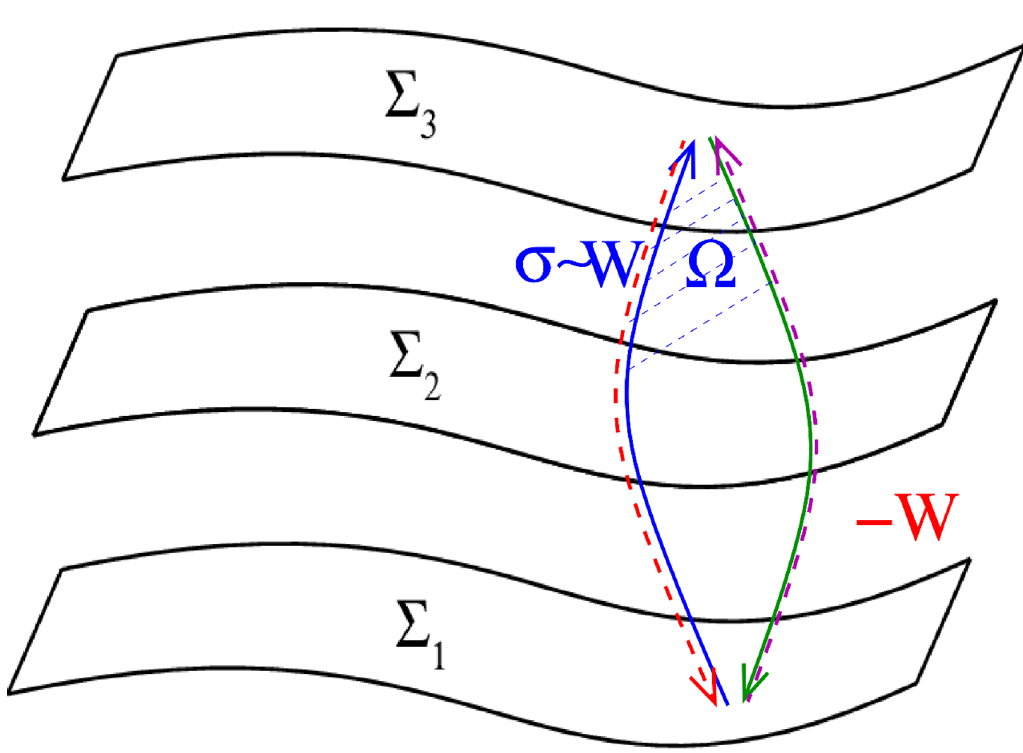
Figure 1 . A generic foliation Σ , with the forward (dissipation-driven) vs backward (fluctuation- driven) direction indicated by solid and dashed lines, and an infinitesimal transformation denoted by Γ